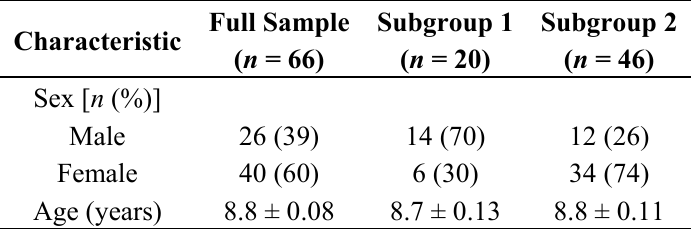
Table 1. Participant characteristics separated by